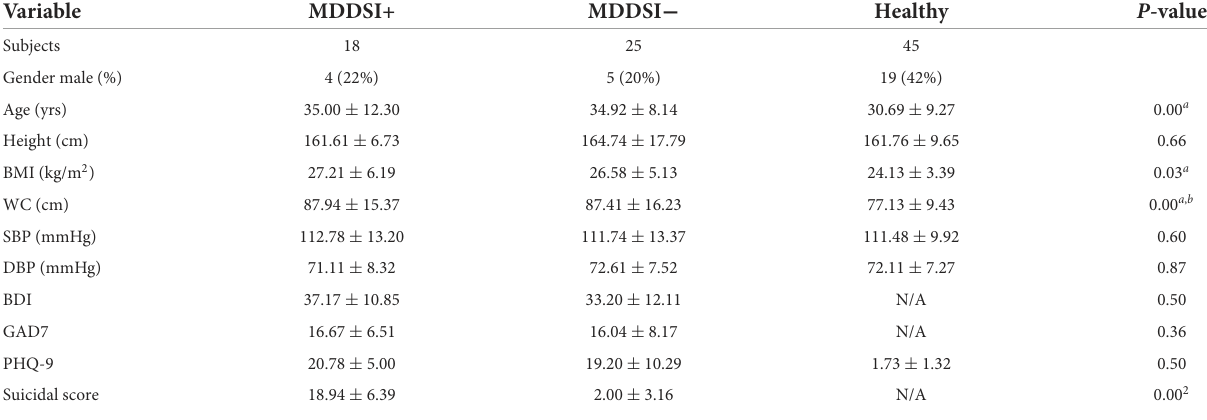
TABLE 2 Dataset subjects’ demographics and psychiatric